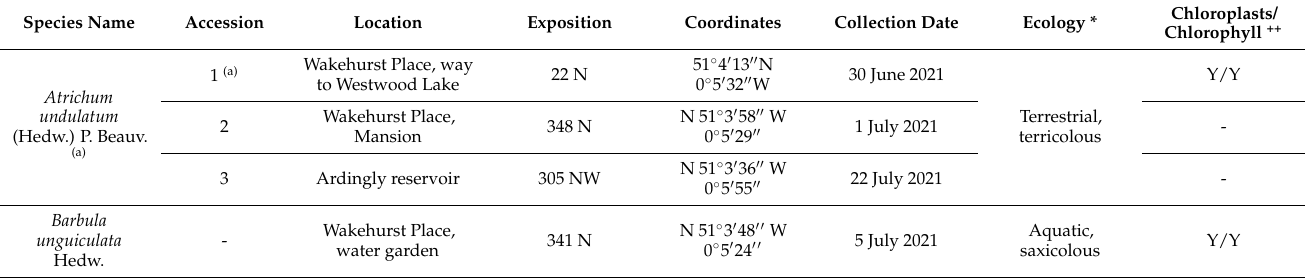
Table 3. Summary of collection data for the species and accessions of bryophytes harvested for this work. Collection data include location, exposition, coordinates, date of collection and ecology. Additionally, the presence of chloroplasts and chlorophyll in the spore samples is